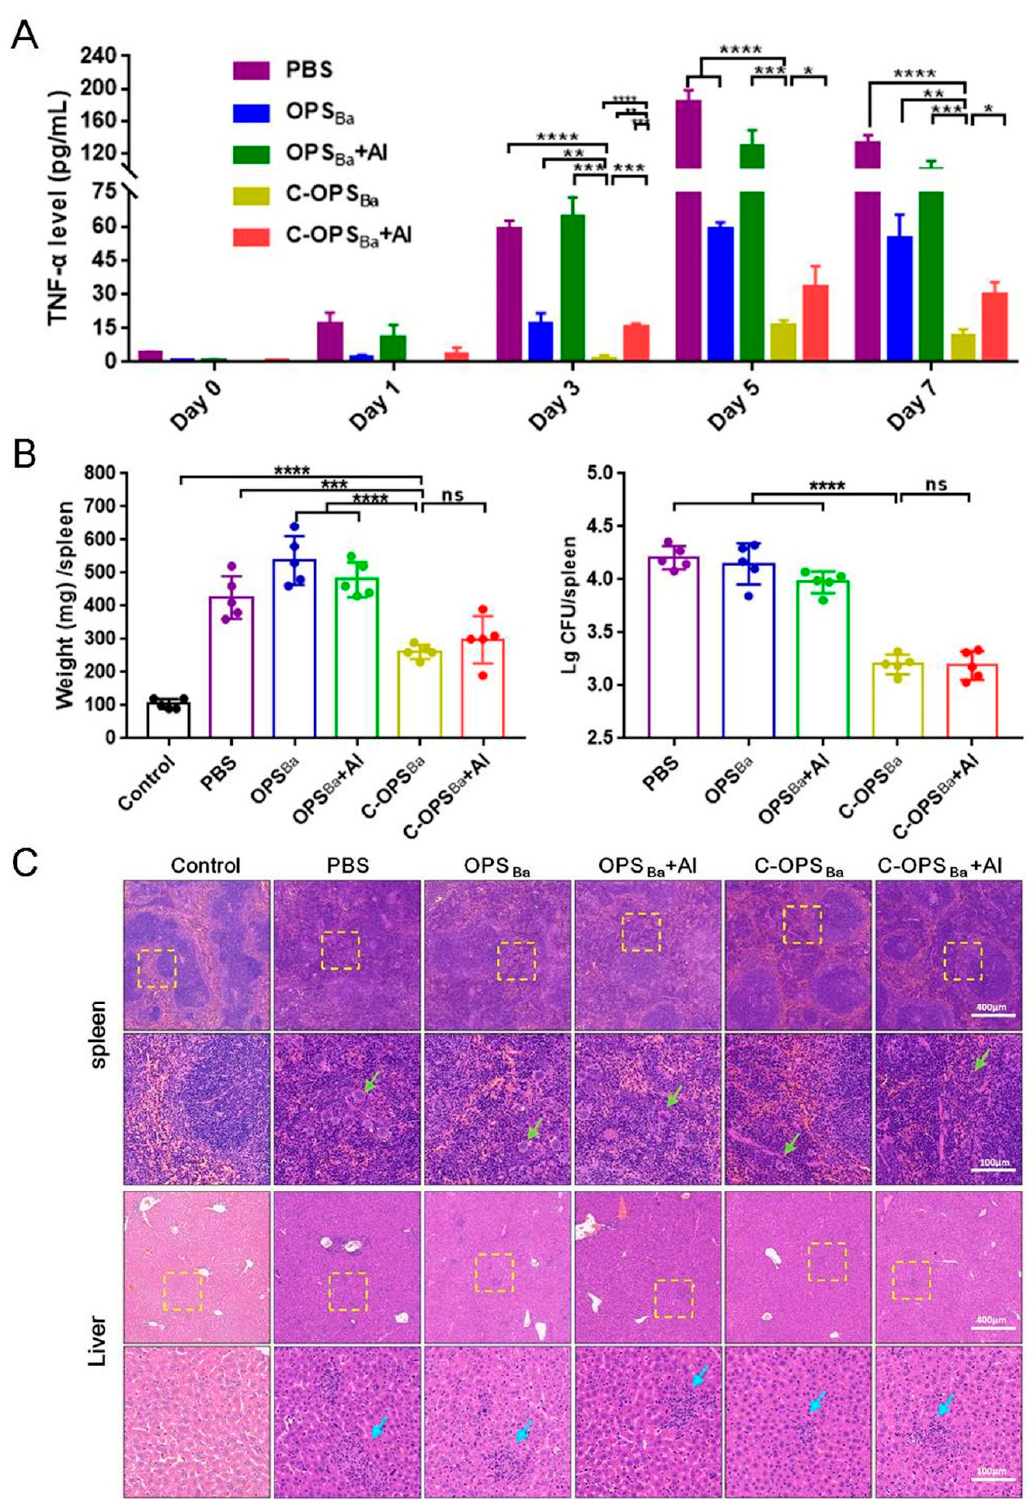
Figure 3. Immune responses of mice following non-lethal B. abortus A19 infection. Immunized mice were infected intraperitoneally with 1.03 × 10 7 CFU of A19 on the 14th day following the third immunization. As a control, another group of naive mice was injected intraperitoneally with normal saline. ( A ) After infection, the sera of mice in each group were collected on the 1st, 3rd, 5th, and 7th day and the TNF- α levels were measured. The unpaired t -test was used to evaluate differences between TNF- α levels at different time points. Each value represents the mean ± standard deviation